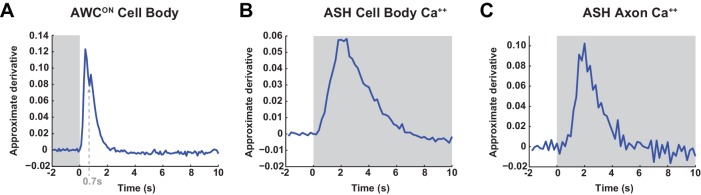
Time derivative of AWCONand ASH GCaMP signals in the cell body and ASH GCaMP signals in the axon. (A) A transition between two positive influx rates may occur ~0.7 s after odor removal, similar to the transition observed in synaptic calcium by syGCaMP recordings in Figure 2G. Average from 47 trials from 16 wild-type animals. (B,C) Time derivative of the mean ASH GCaMP3 signal at the cell body (B) and axon (C) during a 500 mM NaCl stimulus. No heterogeneity of influx rates was detectable with this sensor. Data from Figure 1B. Gray areas mark stimulus periods.